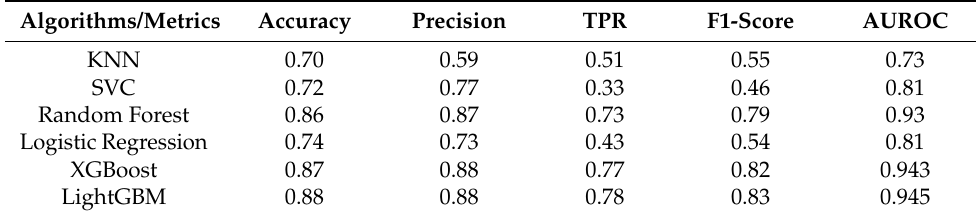
Table 5. A detailed description of the used machine learning algorithms and the metrics used to test these models for exams, including the VRL-based